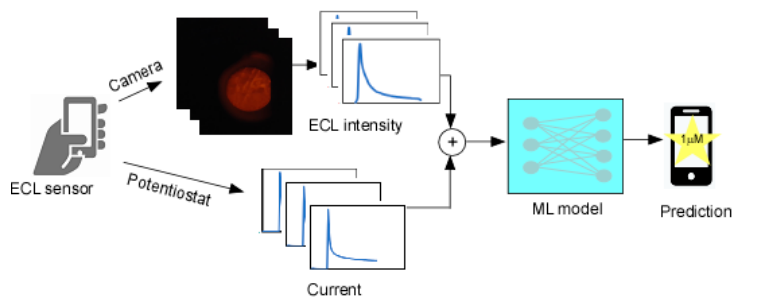
Figure 1. Illustration of entire process of multimodal data collection and prediction process.